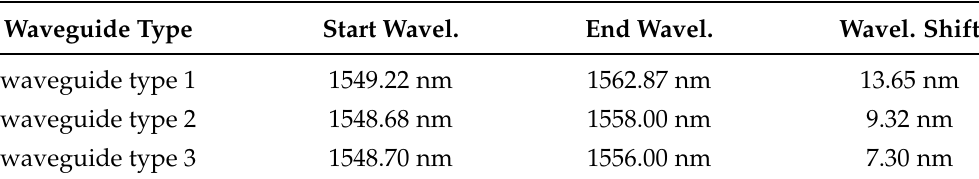
Table 2. Resonance wavelength before and after the deposition of the atomic layer deposition (ALD) layer.